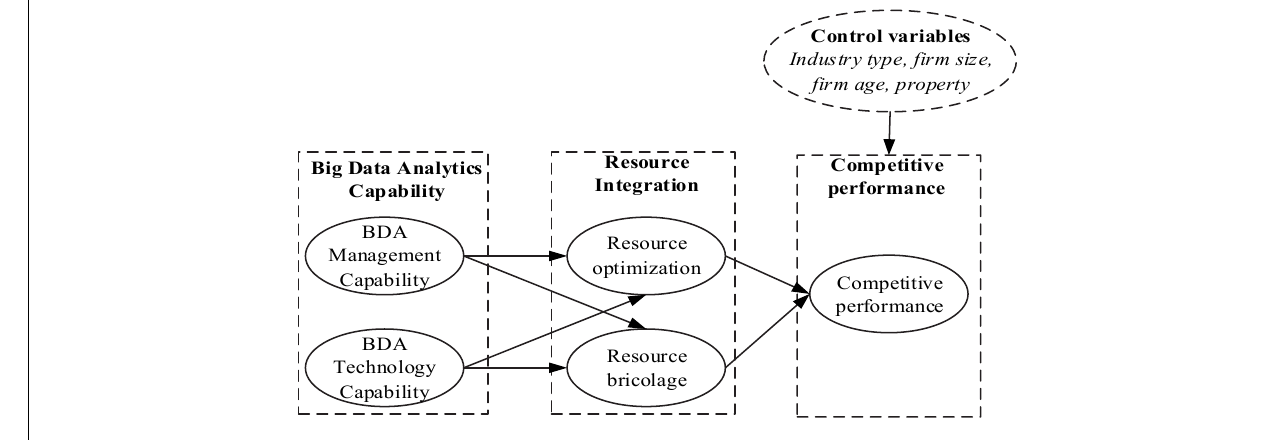
FIGURE 1 | Research model. TABLE 1 | Descriptive statistics of samples ( N =